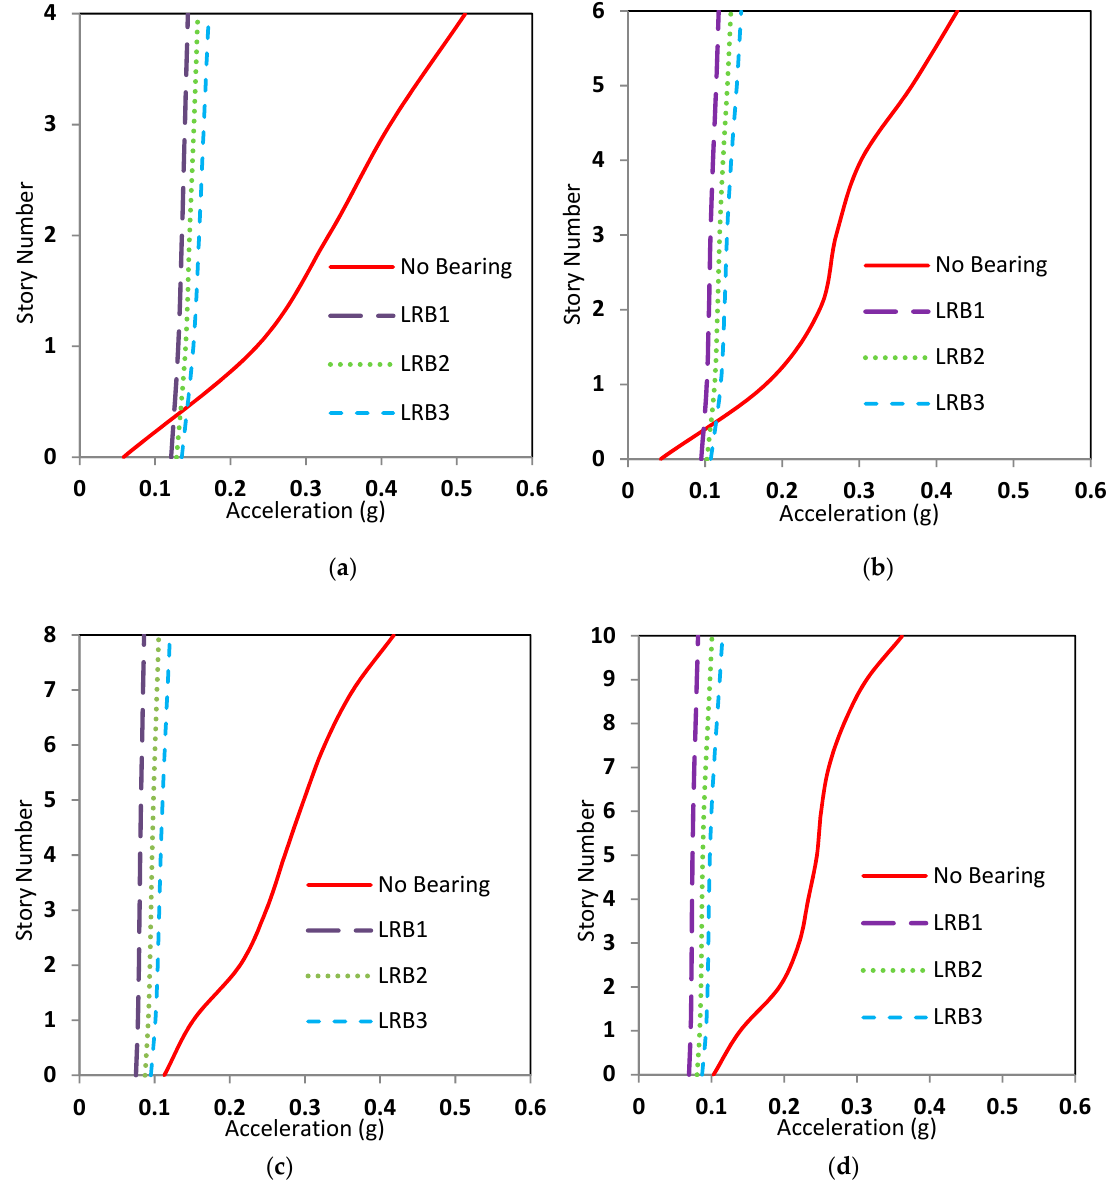
Figure 10. Story accelerations at: ( a ) 4-sStory building, Ti = 1.5 s; ( b ) 6-story building, Ti = 2.0 s; ( c ) 8-story building, Ti = 2.5 s; and ( d ) 10-story building, Ti = 3.0 s.